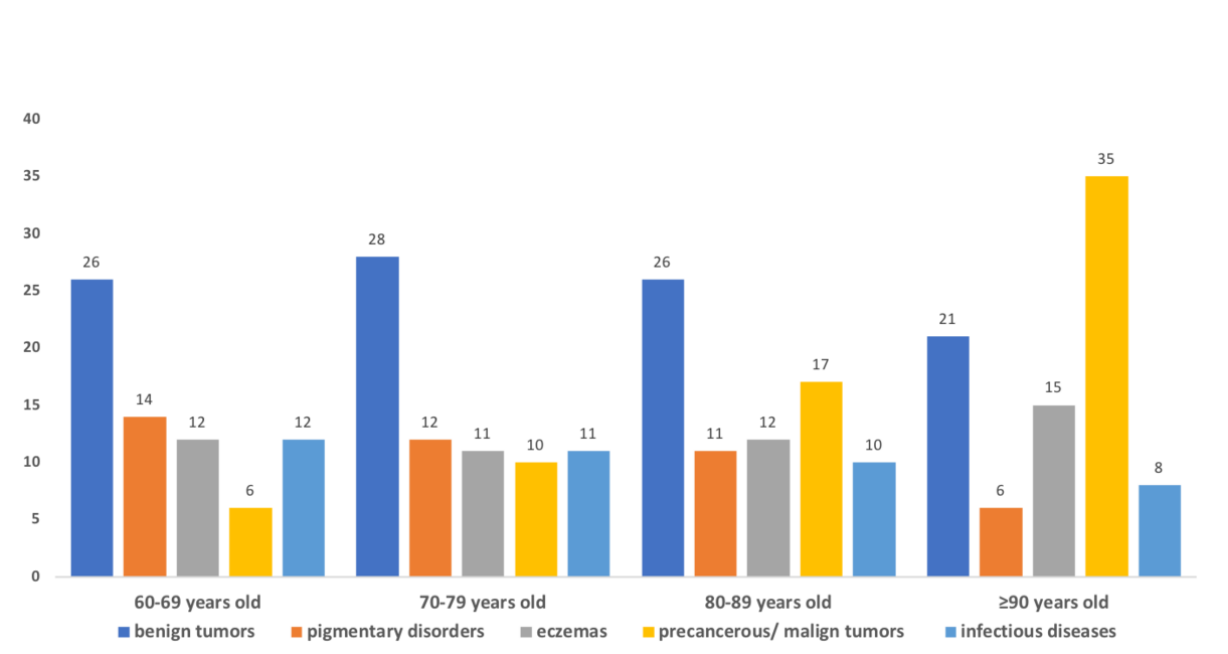
Figure 2. Most frequent group of diseases (%) in patients aged 60 years and older who participated in the teledermatology project by group age from July 2017 to July 2018 in São Paulo, Brazil.